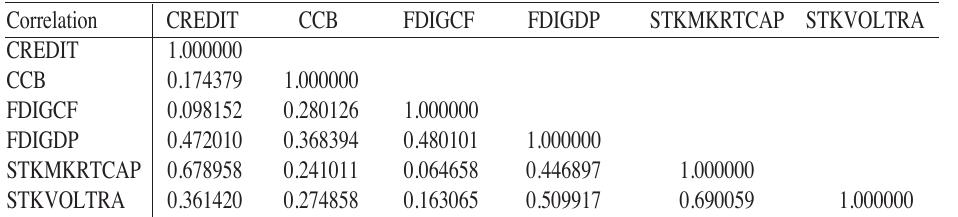
Correlation between FDI and FMD Variables